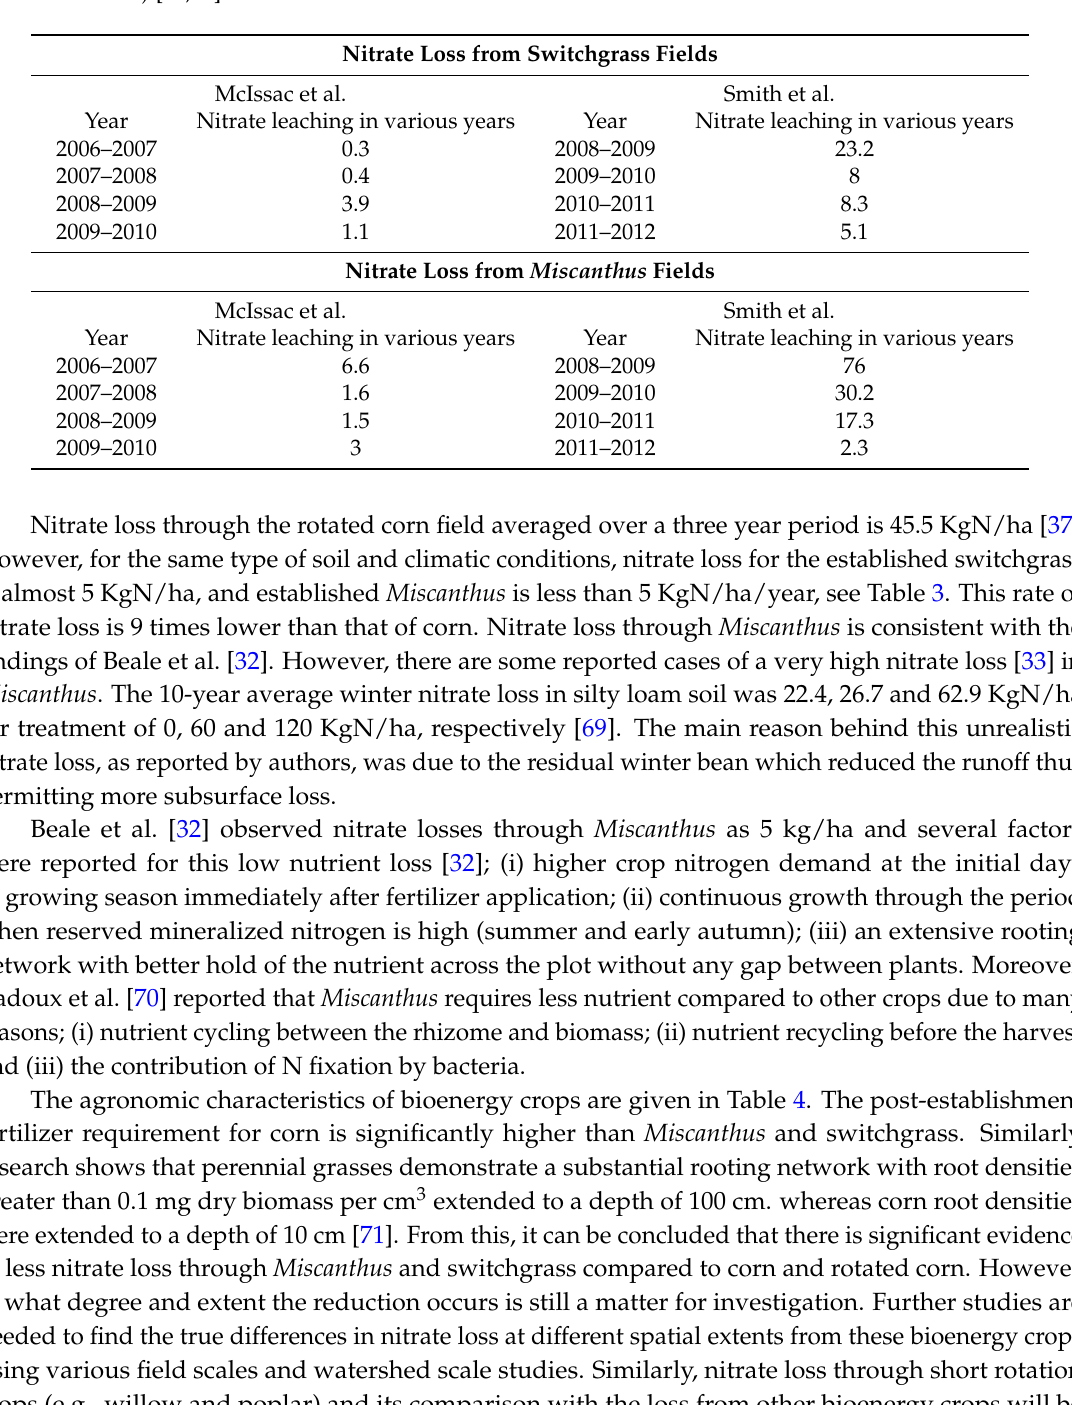
Table 3. Nitrate leaching from swithcgrass and Miscanthus fields (data taken from McIssac et al. and Smith et al.)